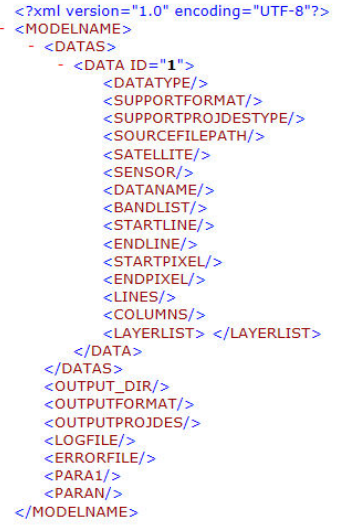
Figure 4. Module parameter definition.